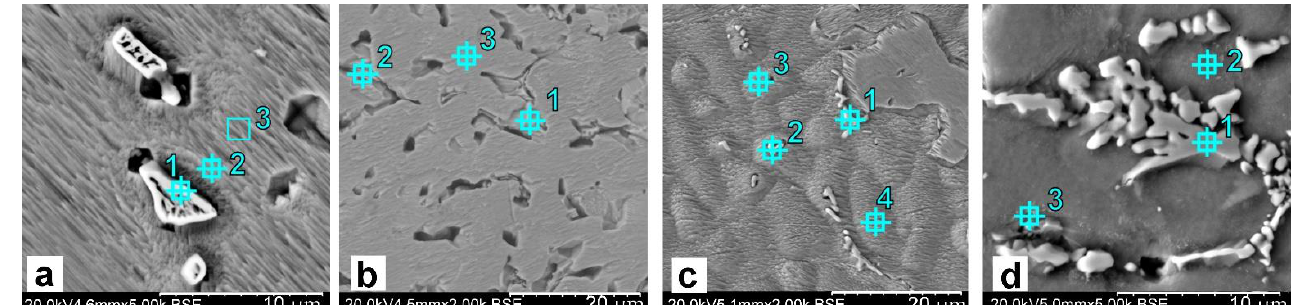
Materials 2021 , 14 , x FOR PEER REVIEW Figure 6. The SEM-EDS image of the alloy surface, metal mould: ( a ) CuSn8; ( b ) CuSn8Ti2; ( c ) CuSn8Ni3Ti0.2; ( d ) CuSn8Ni3Ti2. Table 4. Chemical composition EDS wt.% of CuSn8 alloy for the Figure 6a image.